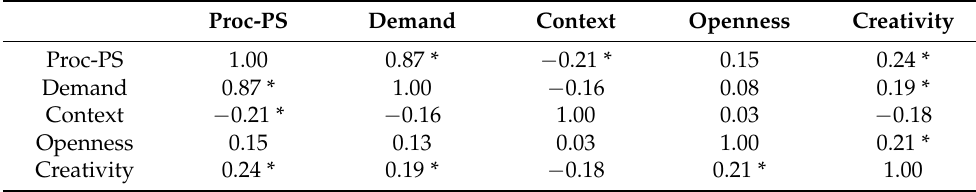
Table 10. Matrix of correlations between